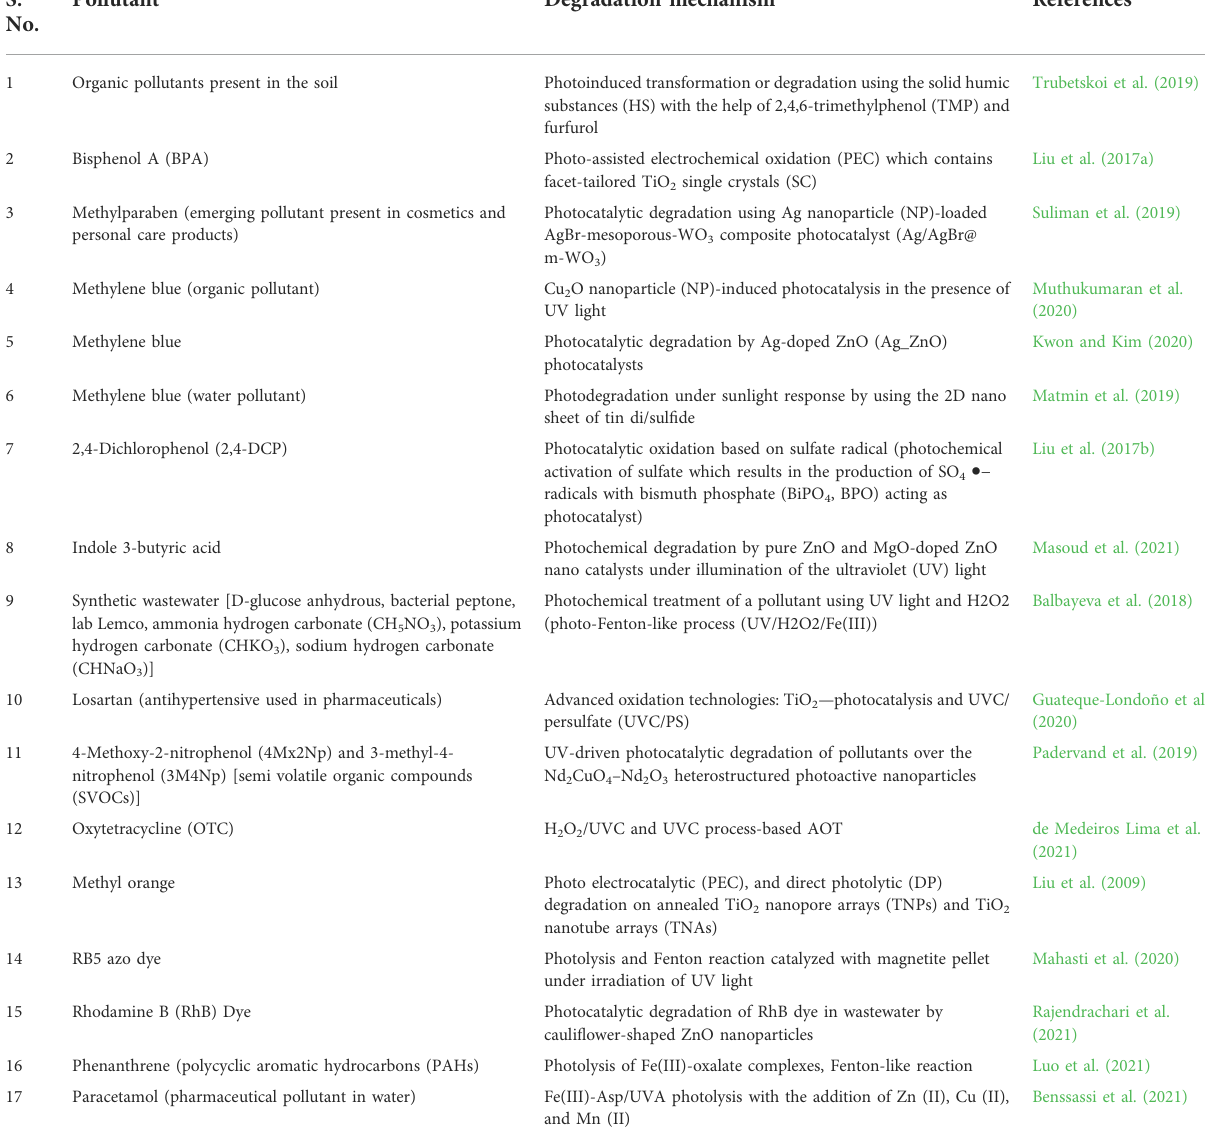
TABLE 3 Degradation of Environmental pollutants by photochemical